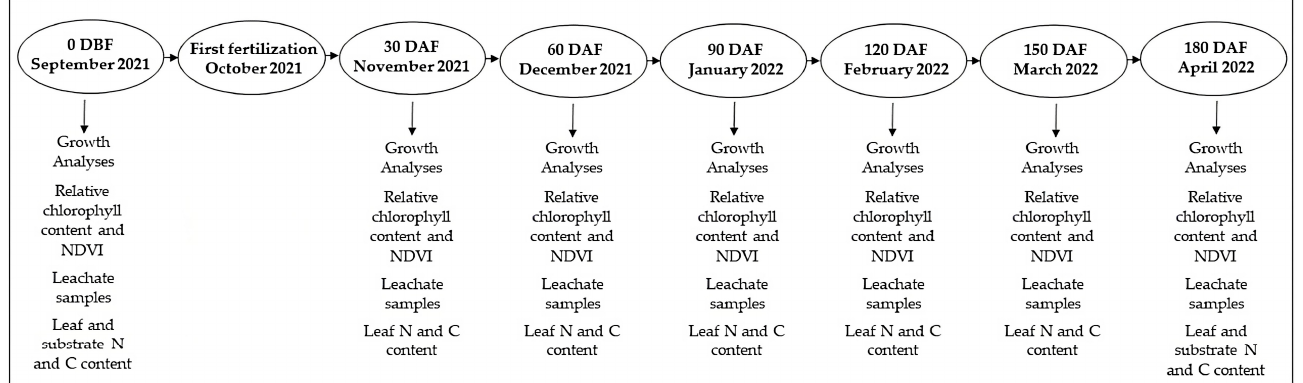
Figure 4. Flowchart with timeline of the sampling. Day before fertilization (DBF)—Base reading. Days after fertilization (DAF).